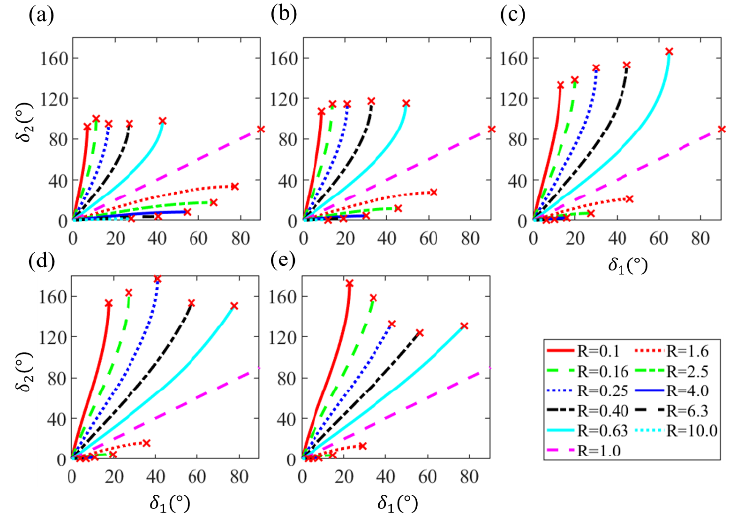
Figure 7. Effect of h 1 on angle magnification in a single four-bar linkage finger structure: ( a ) h 1 = 0.2 L , ( b ) h 1 = 0.5 L , ( c ) h 1 = 1.0 L , ( d ) h 1 = 1.5 L , and ( e ) h 1 = 2.0 L .